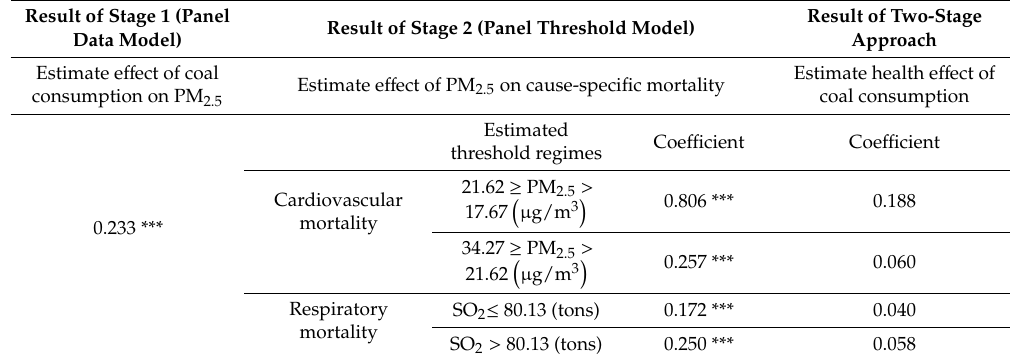
Table 7. Estimation results on the health impacts of coal consumption in air